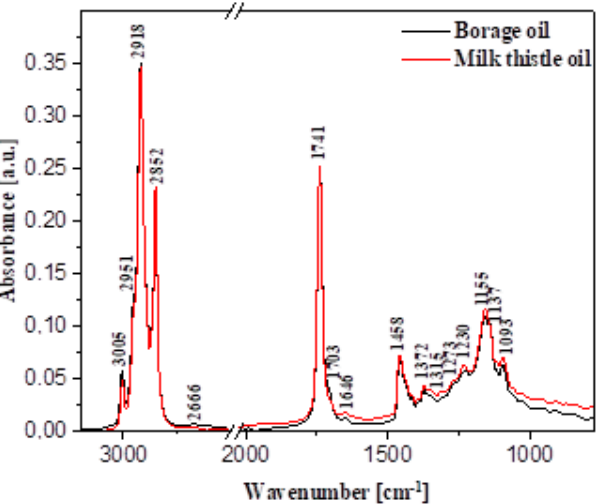
Figure 1. FTIR spectra for the analysed samples of borage oil (black line) and milk thistle oil (red line), measured in the spectral range from 800 to 3200 cm − 1 . The spectra were measured at room temperature.